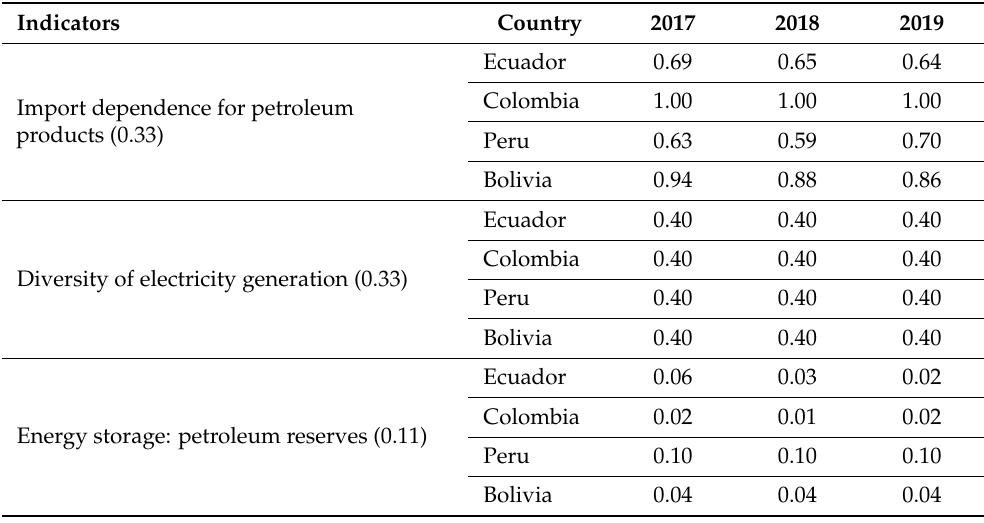
Table 4. The key indicators of the energy security dimension in the members of the Andean Commu- nity